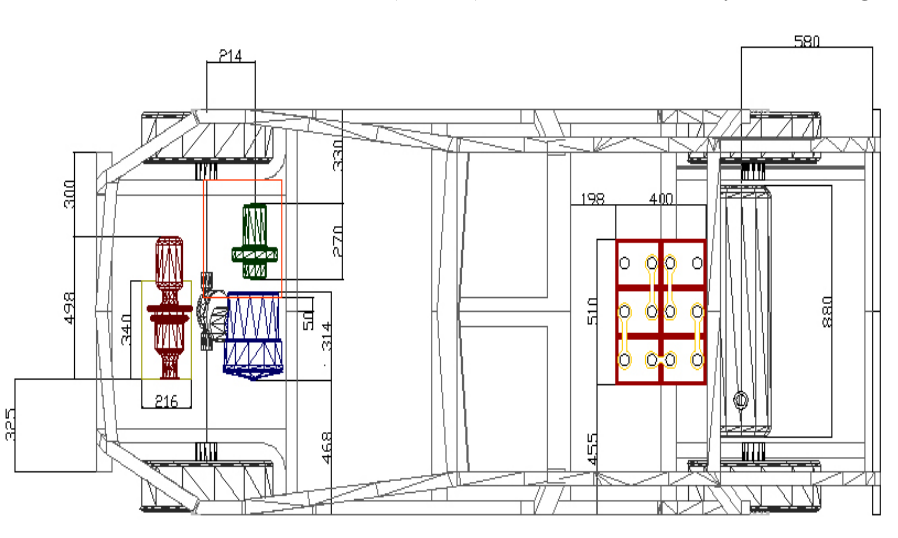
Figure 9. Views and main dimensions (in mm) of the LETHE © City Car